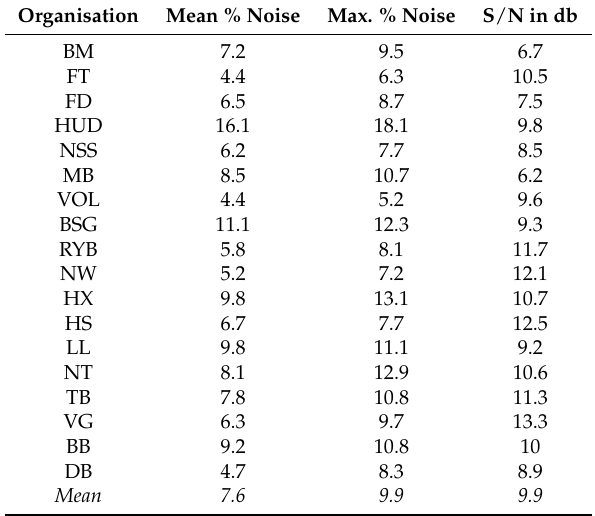
Table 2. Percentage of Noise in Reputation Signals, measured using a Kalman Filter.